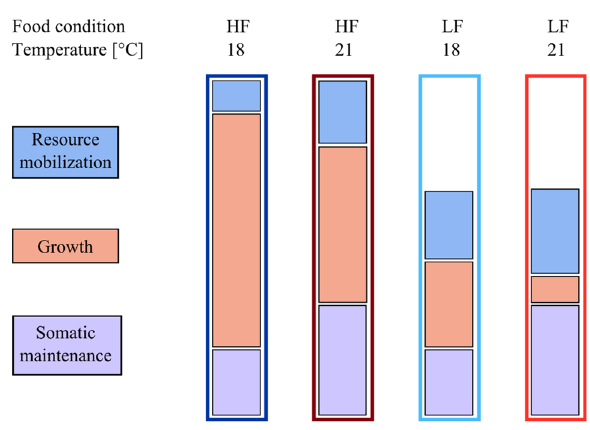
Figure 6. Illustration of resource use in juvenile H. echinata at experimental temperature and nutrient conditions in scenario 1 and 2. Low food limits the overall resource availability for the synthesis of biomolecules and energy production necessary for growth (orange boxes) and somatic maintenance (purple boxes), and increases relative costs for resource mobilization (blue boxes) compared to high food. High water temperature (21 °C) increases energetic and nutritive costs for somatic maintenance and intensifies resource mobilization, while energy availability for growth decreases. At low water temperatures (18 °C), energy can be invested in growth and maintenance, but is limited by food intake. Costs for maturation, reproductive buffer, and maturity maintenance have not been taken into account for juvenile hydroids in this